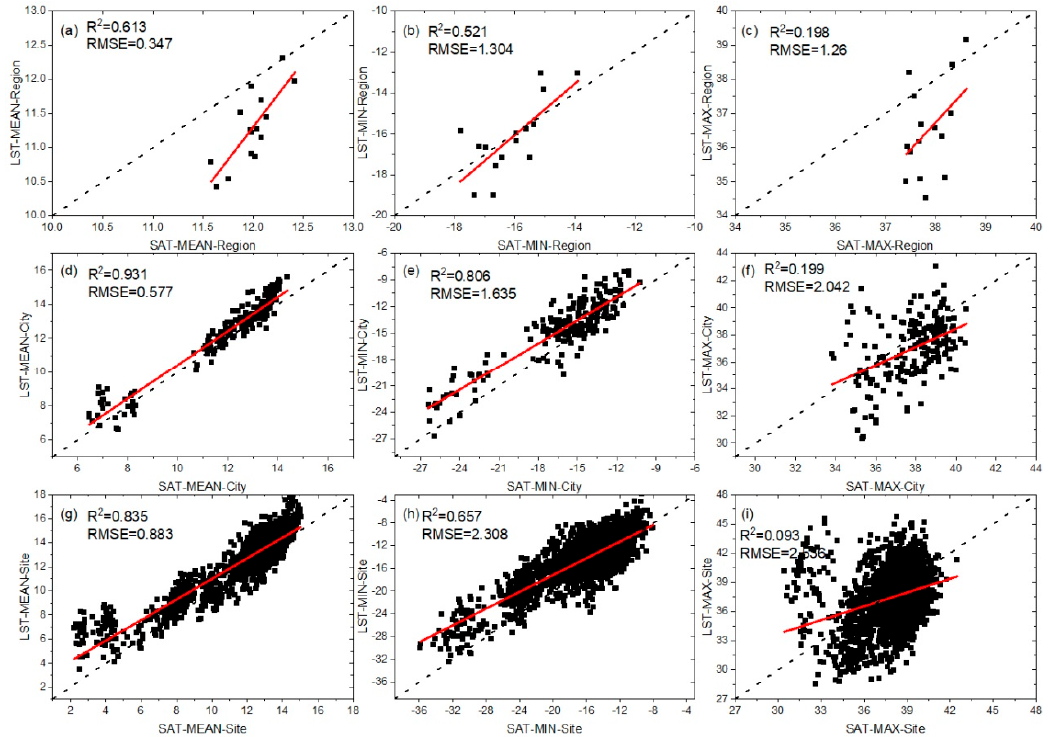
Figure 2. ( a – i ) Regressions between surface air temperature (SAT) and land surface temperature (LST) at regional, city and site scales based on the yearly data (red and dotted lines indicate the fitting and 1:1 line, respectively).